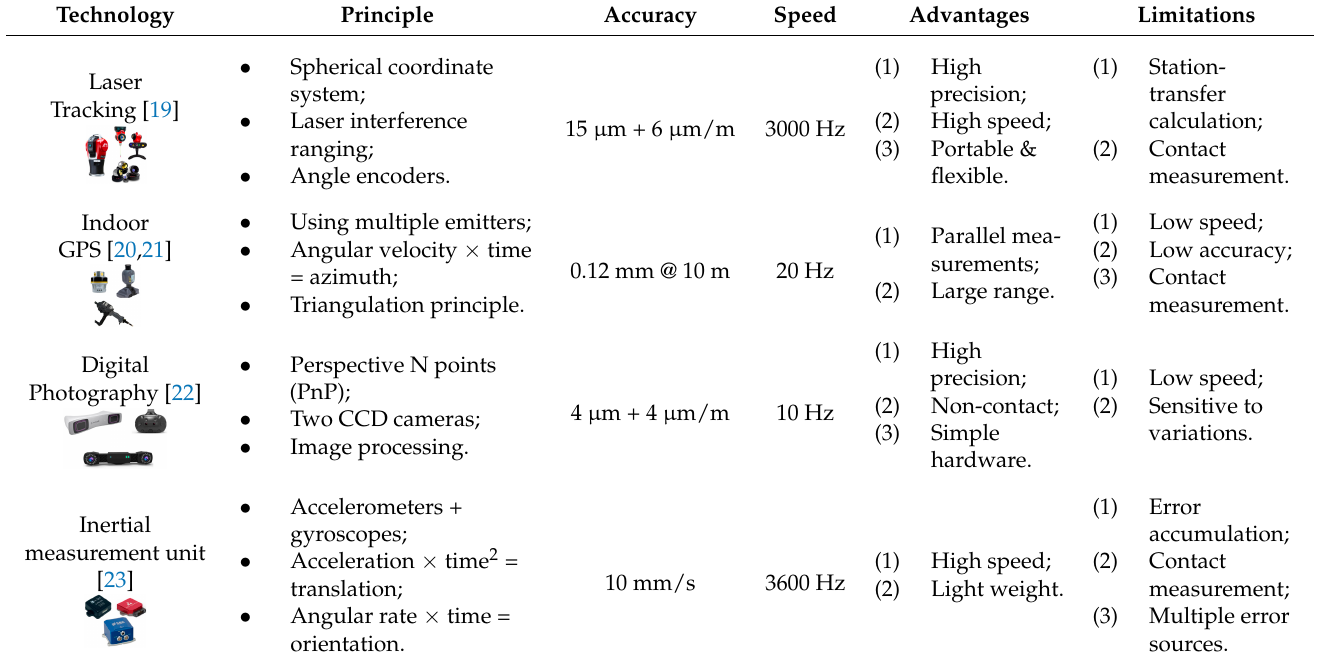
Table 2. Six-DOF measurement technologies.